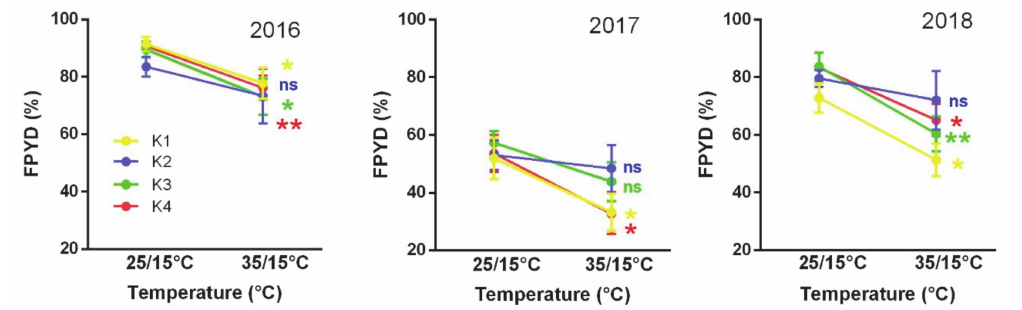
Figure 3. Geographic distribution of studied Medicago truncatula accessions classified into four clusters based on climatic and soil conditions, using Ward’s minimum-variance linkage of Euclidean distance. Grey dots indicate K1, green K2, light blue K3, and yellow K4 cluster, placed on the background of BIO5 (precipitation in the wet quarter).